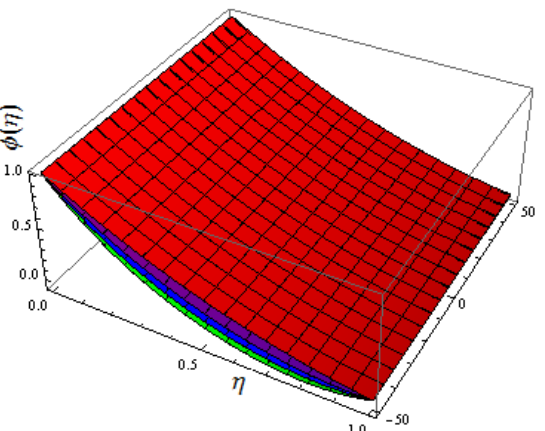
Figure 17. Influence of 𝑁𝑏 on 𝜙(𝜂) .